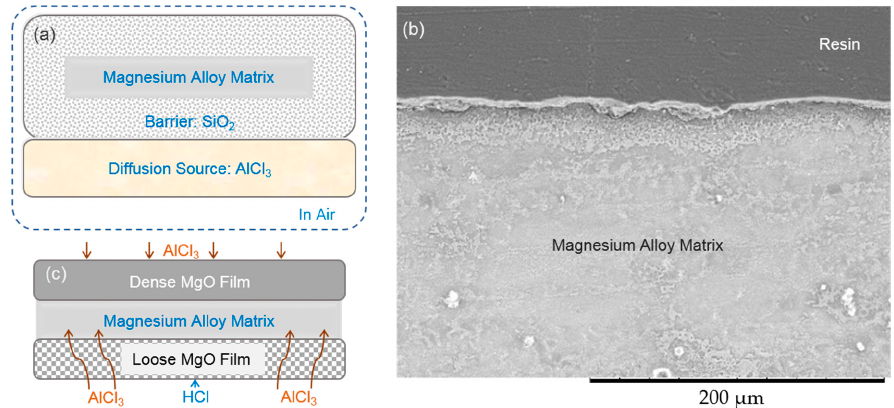
Figure 7. ( a ) The illustration of the powder thermal di ff usion alloying system to investigate the e ff ect of 7 NHCl 4 on the MgO film; ( b ) Cross section of the as-di ff usion alloyed specimen utilizing the di ff usion system shown in ( a ); ( c ) E ff ect of the HCl gas on the MgO